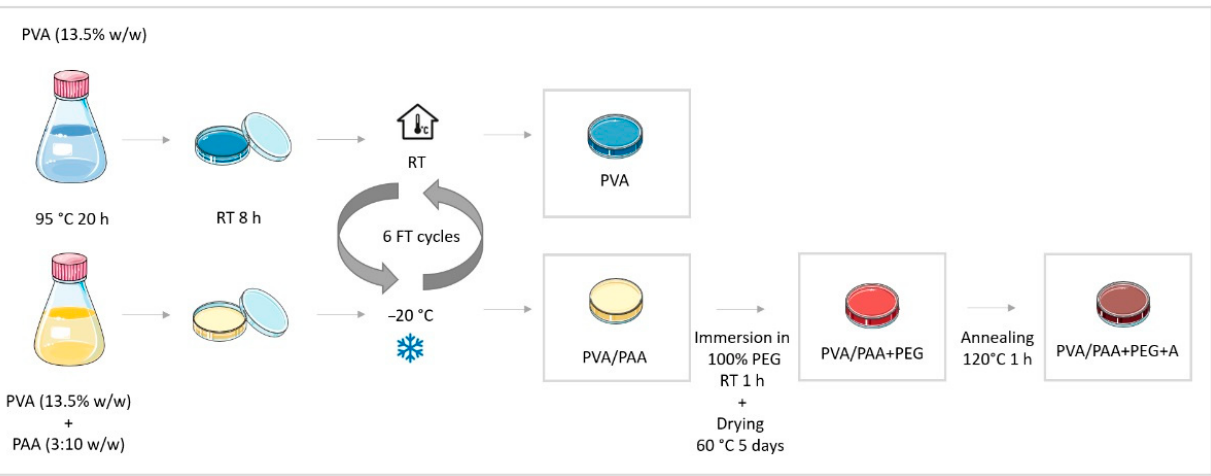
Figure 9. Schematic diagram of the materials’ preparation. RT: room temperature; FT: freeze-thawing. After production, the hydrogels were washed in DD water for 48 h (exchanged at least three times per day) and then stored hydrated till being used. All of them were opaque white and presented an average thickness of 4.8 ± 1.2 mm in the swollen state. Before each characterization test, samples were cut with the proper dimensions, rinsed with DD water, carefully cleaned with absorbent paper, and soaked in fresh DD water for at least 24